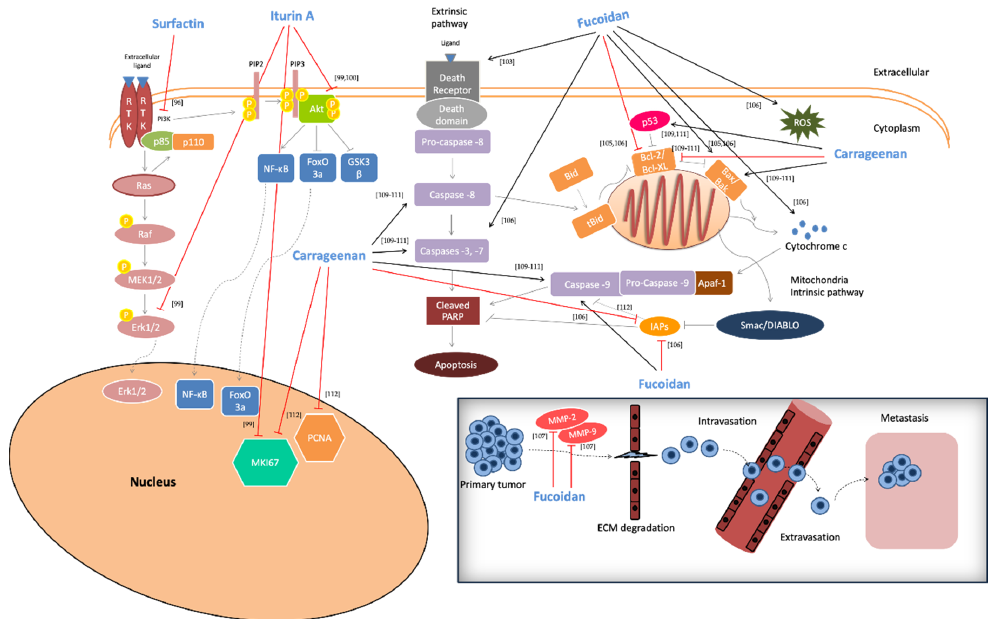
Figure 2. Anti-cancer activity of marine-derived SAAs through induction of both intrinsic and extrinsic apoptotic pathways. Biosurfactants exhibit considerable anti-cancer activity by inhibition of the MAPK/ERK and Akt/PI3K signaling pathways, as well as through suppression of nuclear antigens, MKI67 and PCNA. Their anti-cancer capacity is also mediated through reduced expression of MMPs-2 and -9 known to be associated with tumor metastasis. RTK, Receptor tyrosine kinase; PI3K, Phosphatidylinositol-3-Kinase; MAPK, Mitogen-activated protein kinase; ERK, Extracellular signal–regulated kinase; MEK, MAPK/ERK kinase; PIP 2 , Phosphatidylinositol 4,5-bisphosphate; PIP 3 , Phosphatidylinositol (3,4,5)-trisphosphate; NF-kB, Nuclear factor kappa-light-chain-enhancer of activated B cells; FOXO3a, Forkhead box O3a; GSK3β, Glycogen synthase kinase 3 beta; MKI67, Marker of Proliferation Ki-67; PCNA, Proliferating Cell Nuclear Antigen; PARP, Poly (ADP-ribose) Polymerase; Bid, BH3-interacting domain death agonist; tBid, truncated Bid; Bcl-2, B-cell lymphoma 2; BCL-XL, B-cell lymphoma-extra-large; BAX, BCL2 associated X; BAK, BCL2-antagonist/killer; ROS, Reactive oxygen species; Smac/DIABLO, Second mitochondria-derived activator of caspase/direct inhibitor of apoptosis-binding protein with low pI; IAPs, Inhibitors of apoptosis protein; Apaf-1, Apoptotic protease activating factor 1; MMP-2, Matrix metalloproteinase-2; MMP-9, Matrix metalloproteinase-9; ECM, Extracellular matrix.